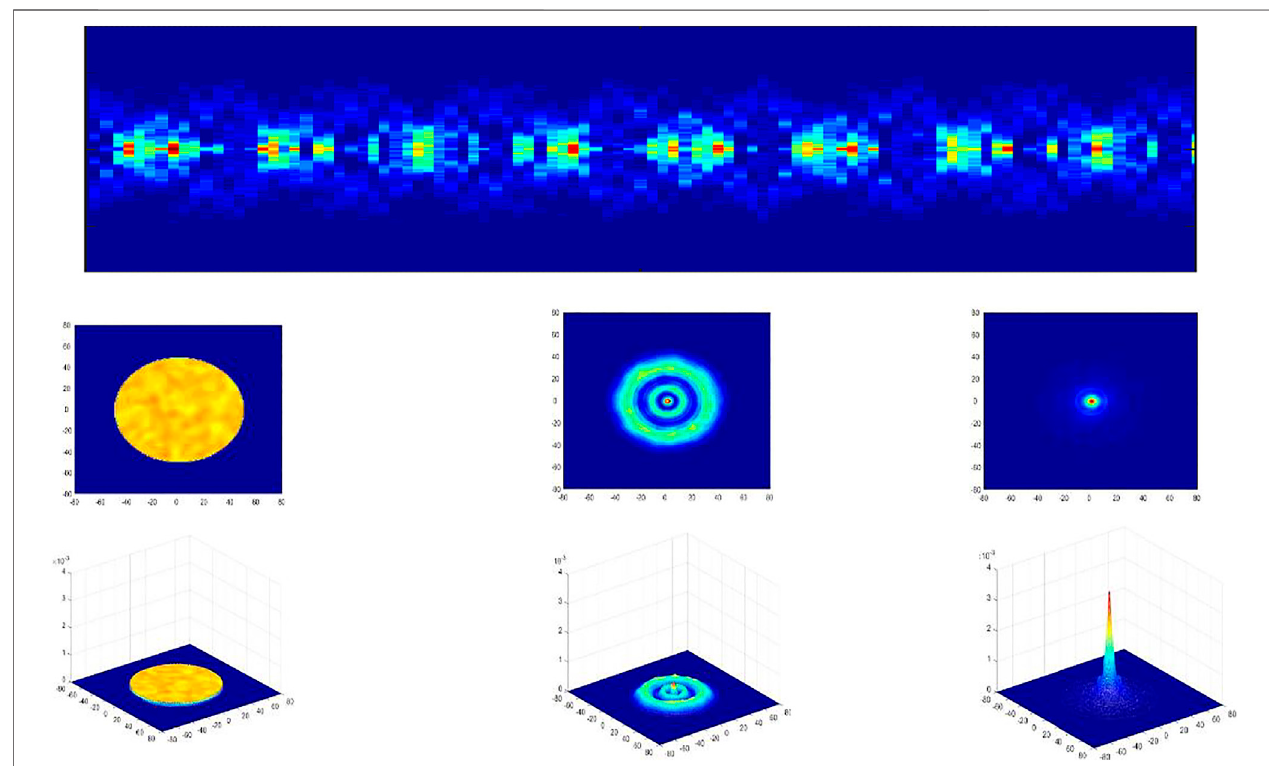
FIGURE 1 | Localzation of light due to mode couplings from MM beam propagation in MM core fi ber. (A) Spacial distribution of power change along the propagation with strong localization spots. (B) and (C) : 2D and 3D spatial distribution of power at some locations of the fi ber.